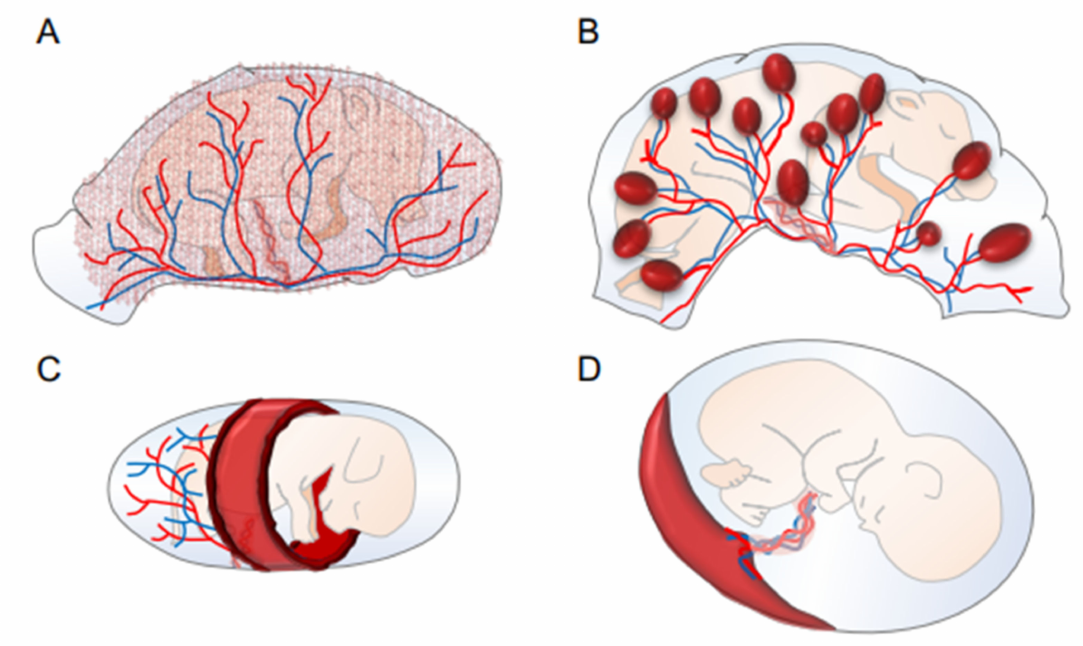
Figure 1. Structural diversity of placentas as classified by the distribution of chorionic villi. Gross anatomy showing diffuse (pigs), cotyledonary (ruminants), zonary (cats and dogs), and discoid (rodents and primates). ( A ): Diffuse placentas have a uniform distribution of chorionic villi covering the chorion’s surface. ( B ): Cotyledonary placentas have numerous, discrete, button-like structures called cotyledons and they join with the maternal caruncle, forming a placentome. ( C ): Zonary placentas have a band-like zone of chorionic villi, of which both edges are primary exchange zones. ( D ): Discoid placentas form a regionalized disc-like structure. Red and blue lines are the artery and vein, respectively, which are joined to an umbilical